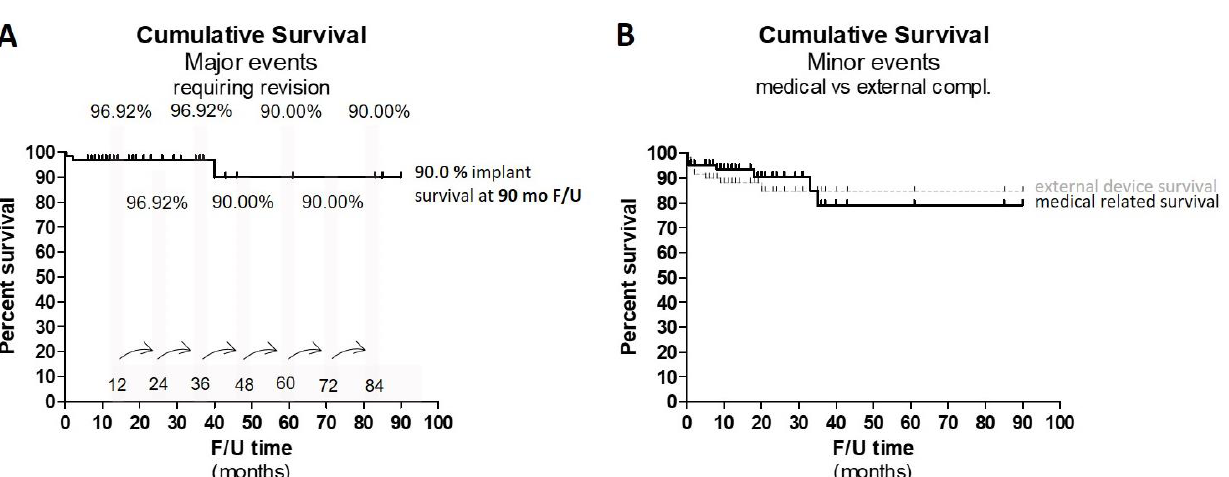
Table 2. Audio Processor Satisfaction Questionnaire (APSQ).